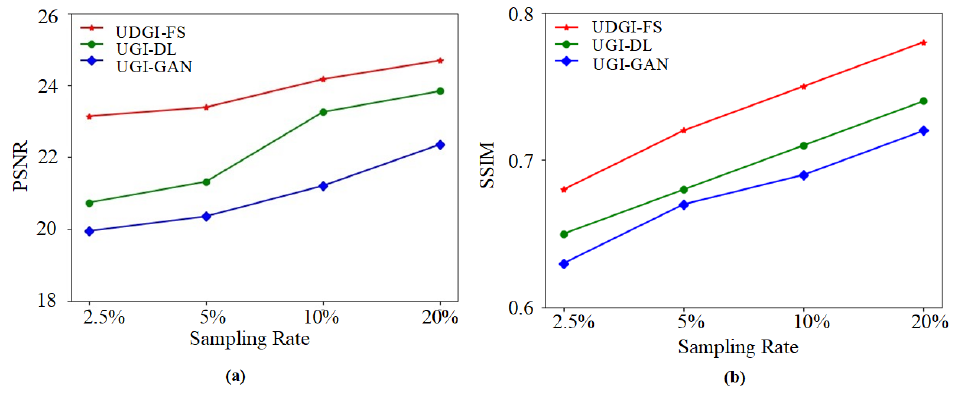
Figure 15. The PSNRs and SSIMs of the reconstructed shark images of UDGI-FS, UGI-DL, and UGI-GAN at different sampling rates. ( a ) PSNRs of the reconstructed shark images of UDGI-FS, UGI-DL, and UGI-GAN at different sampling rates; ( b ) SSIMs of the reconstructed shark images of UDGI-FS, UGI-DL, and UGI-GAN at different sampling rates.